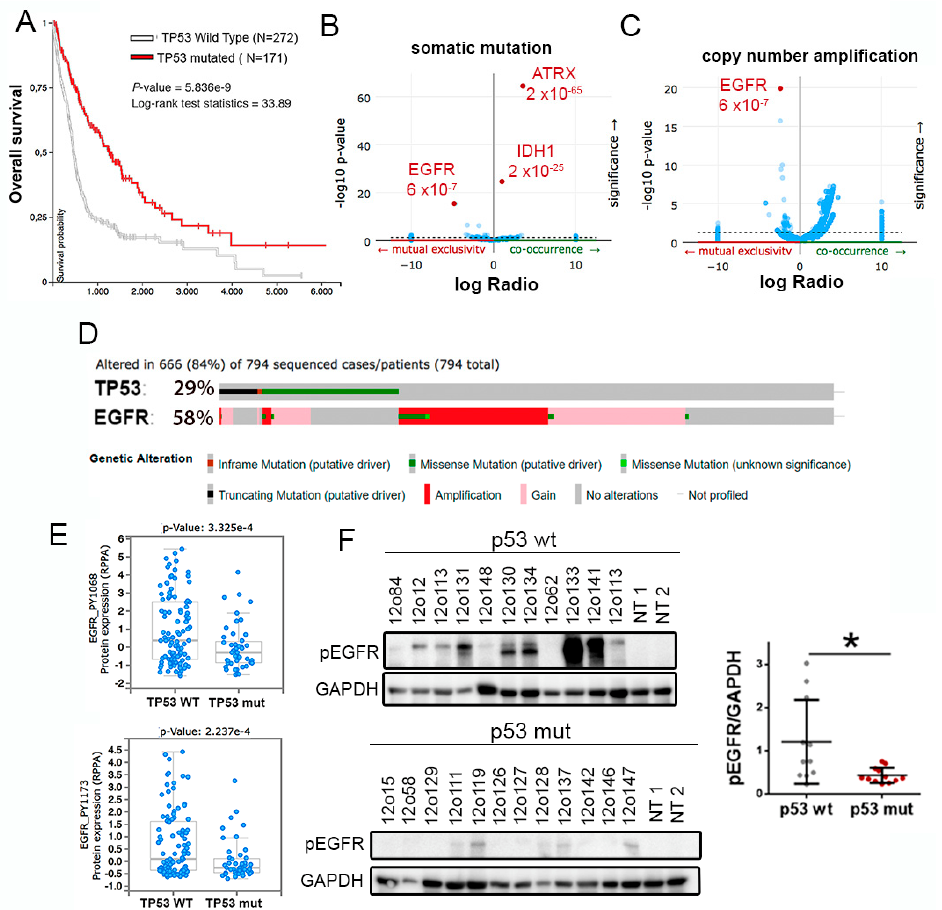
Figure 1. Opposite distribution of TP53 and EGFR alterations in gliomas. ( A ) Kaplan–Meier overall survival curves of patients from the TCGA LGG + GBM cohort. Patients were separated on the basis of the status of TP53. ( B , C ) Volcano plots showing mutated genes. ( B ) or copy number amplified genes ( C ) with differential distribution in gliomas, comparing TP53 wild-type and TP53 mutated tumors. ( D ) Distribution of somatic non-silent mutations in EGFR and TP53 in a glioma cohort (TCGA LGG + GBM dataset). ( E ) Analysis of levels of Phospho-Tyr1068-EGFR and Phospho-Tyr1173-EGFR in a cohort of patients with glioma (TCGA LGG + GBM dataset), according to the status of TP53. ( F ) Western blot (WB) analysis and quantification of Phospho-Tyr1068-EGFR (pEGFR) in tumor tissue extracts from patients diagnosed with glioma. Patients were separated based on the status of TP53. GAPDH protein levels were used as a loading control. NT: Normal Tissue. * p ≤